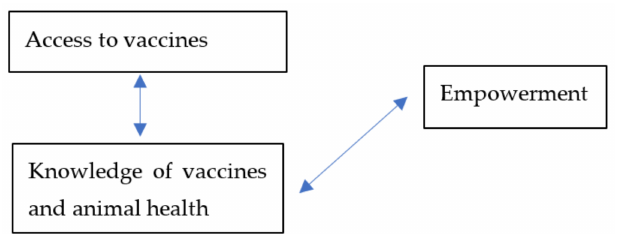
Figure 6. Illustration of the PLS-SEM model results on the relationship between access to vaccines and empowerment.